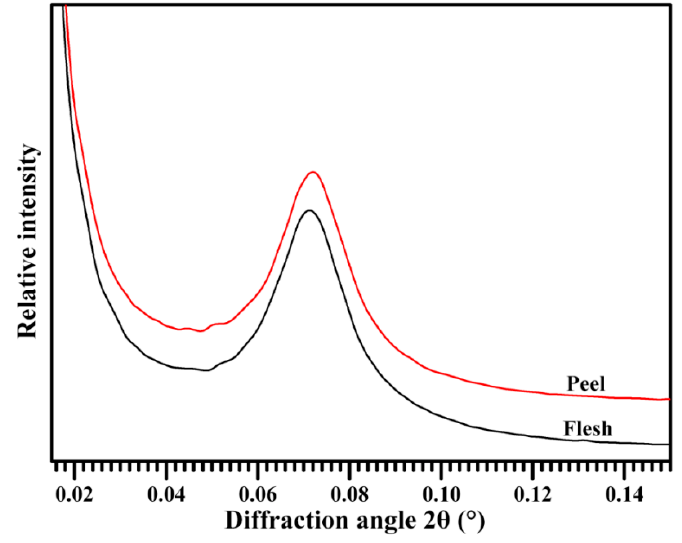
Figure 5. Small-angle X-ray scattering (SAXS) patterns of starches.